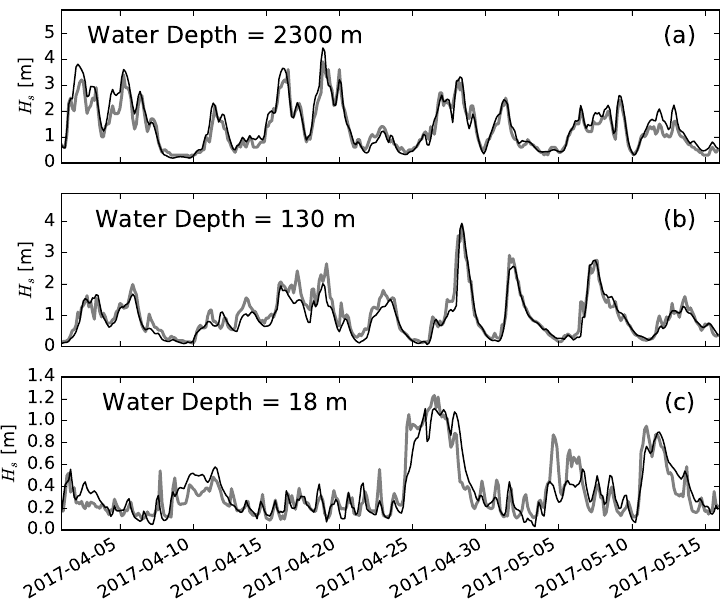
Figure 5. Comparisons between predictions and measurements of H s time series at Lion buoy ( a ), La Revellata buoy ( b ) and AWAC at the Poetto beach ( c ). Thick gray line: observations; thin black line: